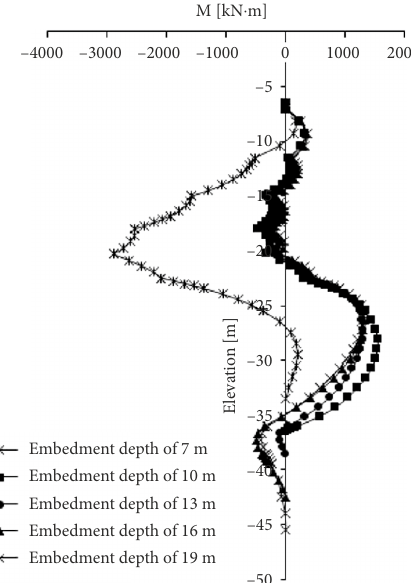
Figure 14. Influence of different insertion ratios on the bending moment